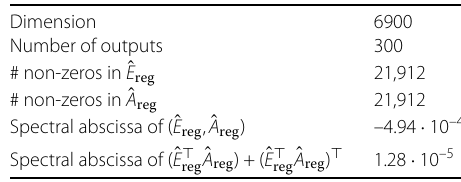
Table 5 Properties of regularized stochastic Galerkin system in band-pass filter example